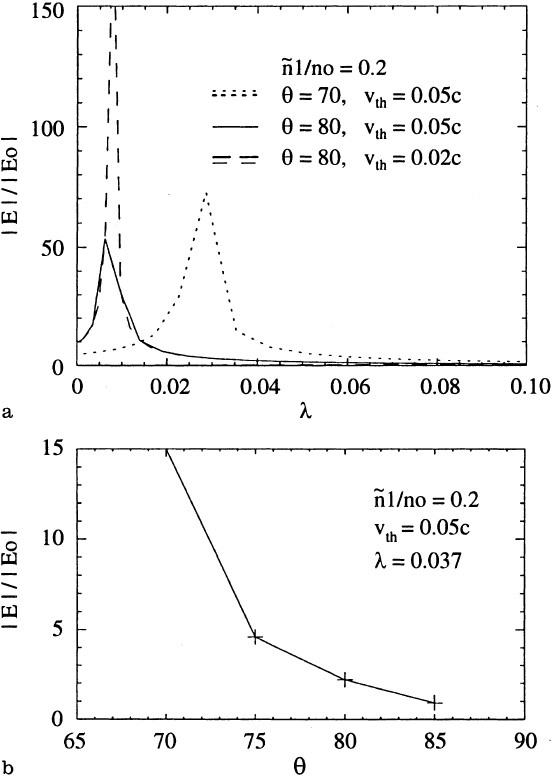
Fig. 9a,b. Calculation of the ratio of the UH wave amplitude to the pump wave amplitude as functions of a (cid:107) , b